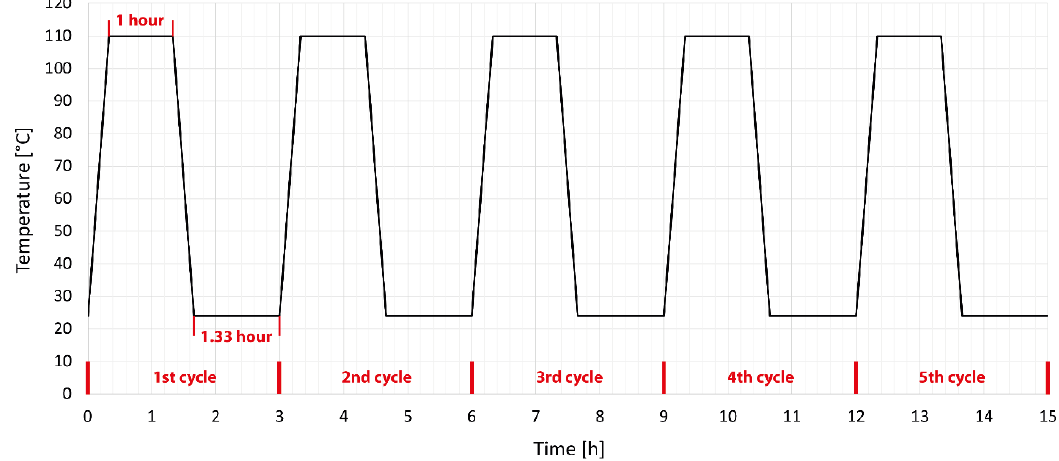
Figure 2. Setting temperature aging cycle of HDPE under the melting point [38].